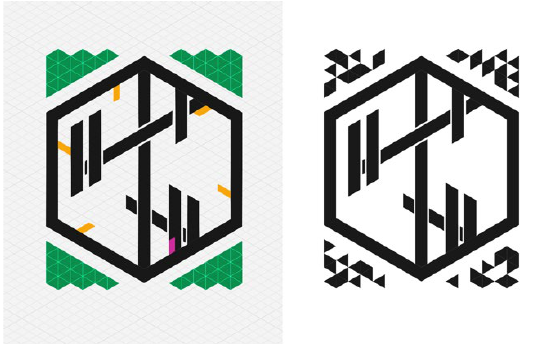
Figure 7. Example of marker developed for the INWIT sites, based on the Vuforia VuMark service. The left part of the image highlights components such as the variable pattern for code registration (green) and the relevant portions used to establish orientation (purple and yellow). Graphics inside the hexagonal border are not used for recognition